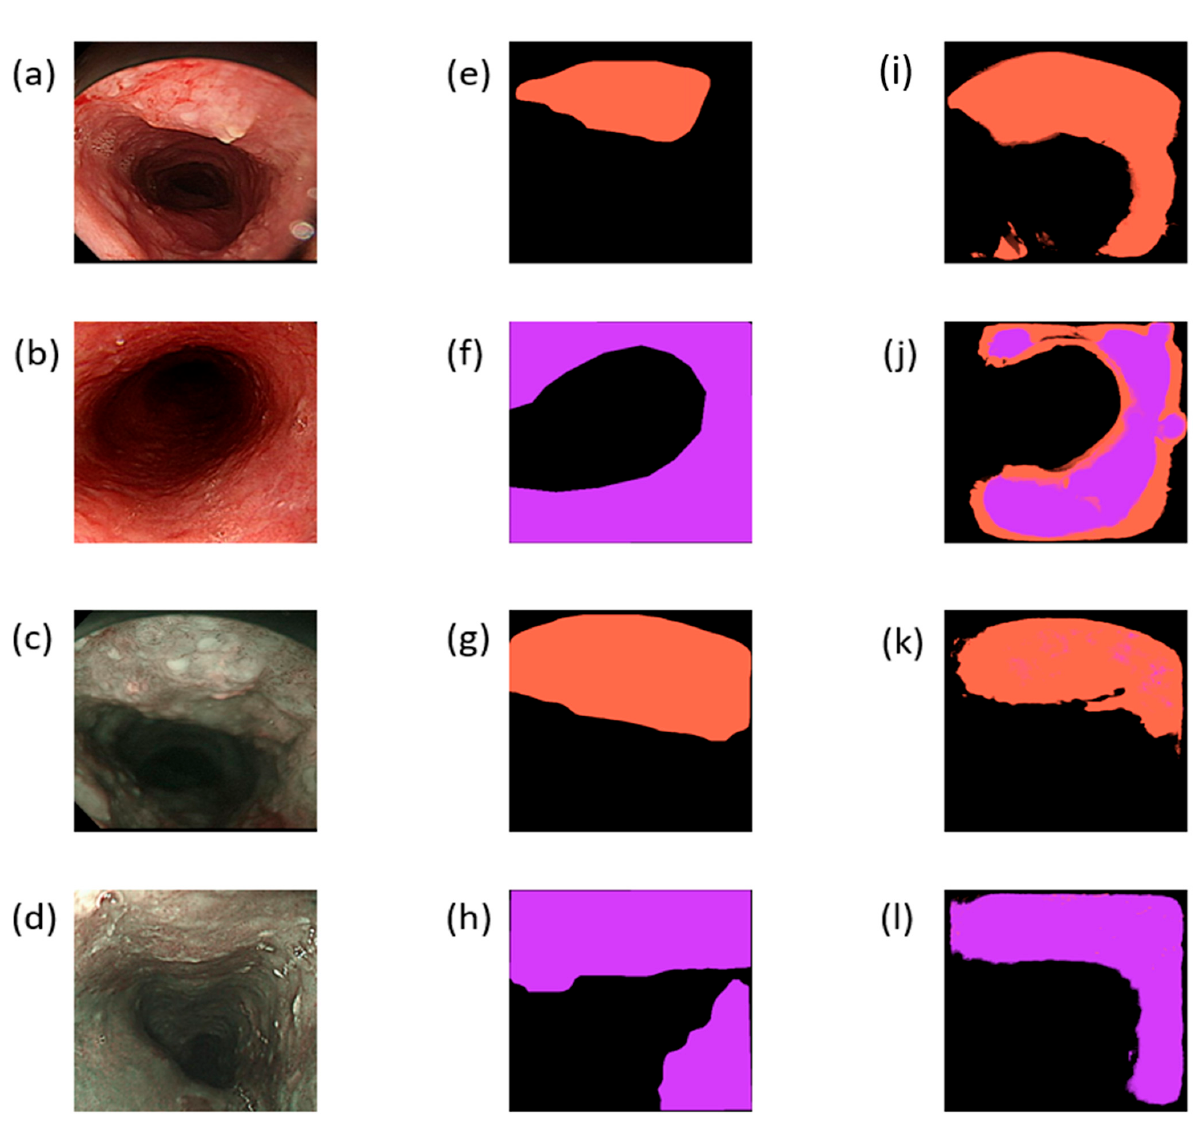
Figure 2. ( a , b ) Input images after cropping the original WLI images; ( c , d ) input images after cropping the original NBI images. ( e – h ) Ground-truth maps marked by doctors based on the corresponding input images. ( i – l ) Prediction results of the corresponding graphs; the orange mark corresponds to SCC, whereas the purple mark corresponds to dysplasia. Table 1. Confusion matrix for narrow-band imaging.